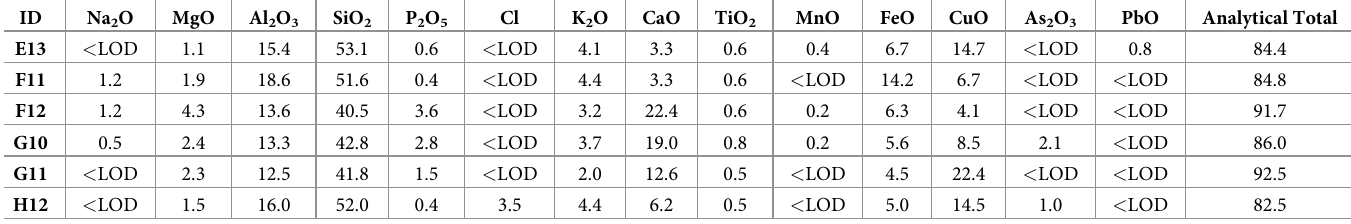
Table 5. SEM-EDS results (wt%) of bulk slag analyses.